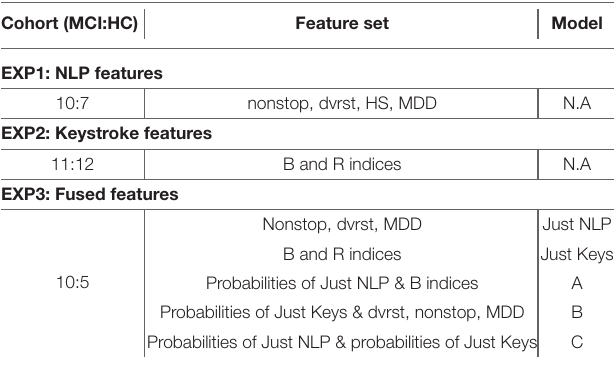
TABLE 5 | Results of the three experiments with NLP features, keystroke features and their combination in cascaded